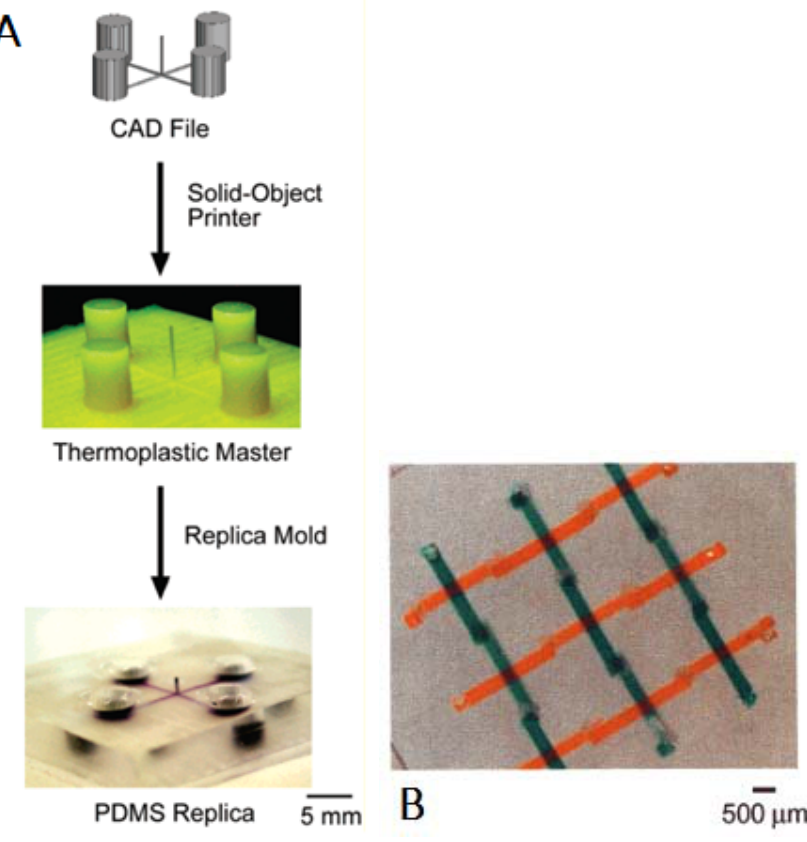
Figure 2. ( A ) Scheme for prototyping devices in polydimethylsiloxane (PDMS) using solid-object printing; ( B ) Basket weave pattern for crossing, nonintersecting channels. (Reproduced with permission from [40].)